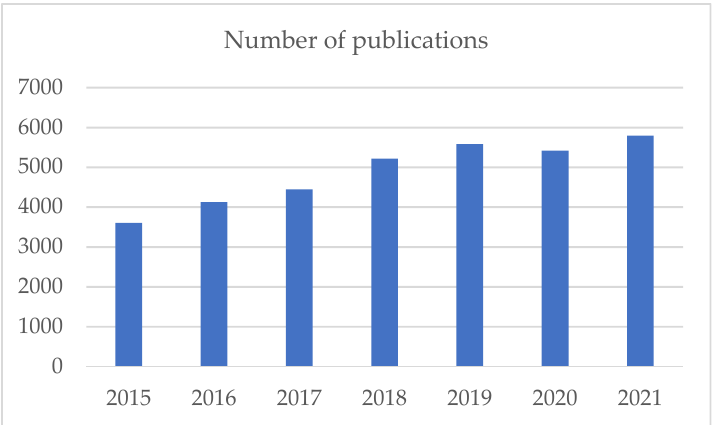
Figure 2. The number of publications on energy storage within the last seven years.